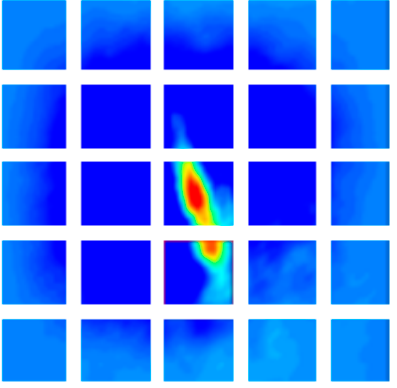
Figure 4. Divided response patch.